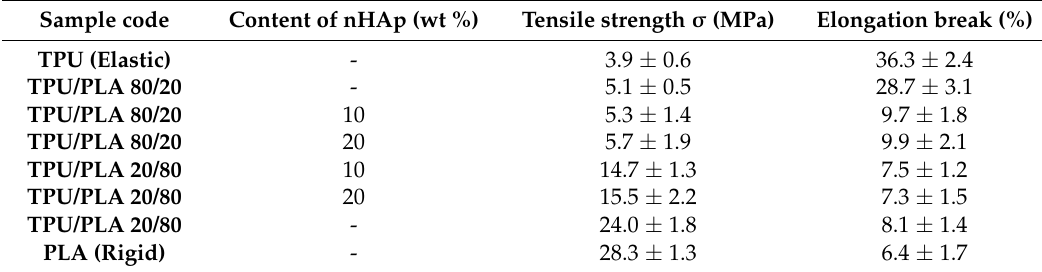
Table 8. Mechanical properties of the blend of TPU and PLA doped with nano-hydroxyapatite in comparison with pure polyurethane and polylactide—tensile